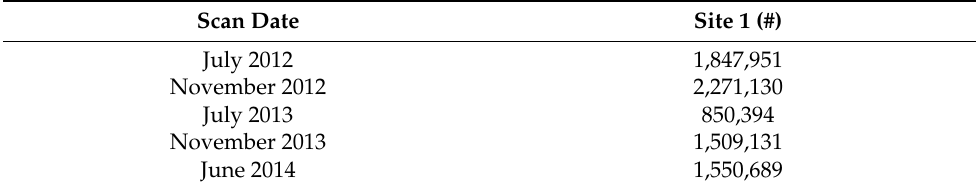
Table 2. Dates and data acquisition techniques for Site 1.